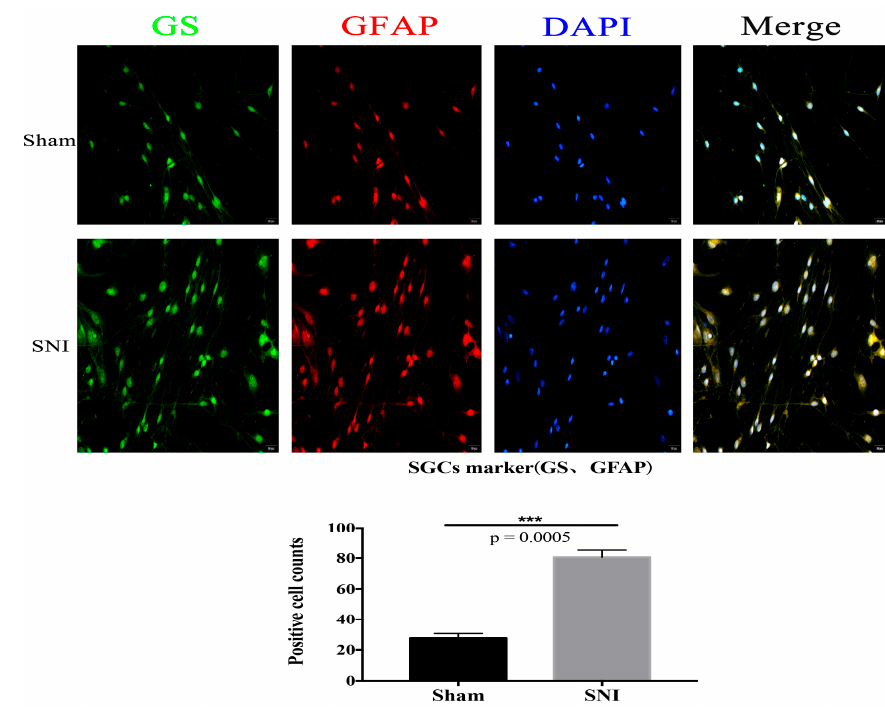
Figure 5. The co-labeling results of GS and GFAP (Scale bar: 20 μ m, 40×) (*** p = 0.0005).